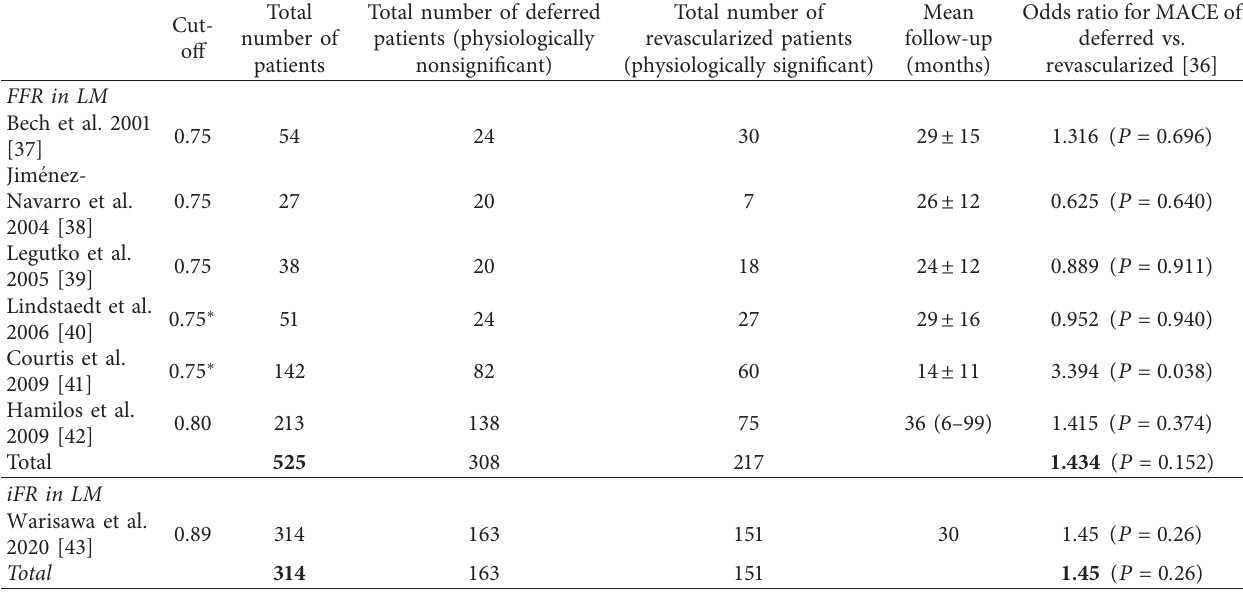
Table 1: LM revascularization decision making based on FFR or iFR: observational outcome studies.